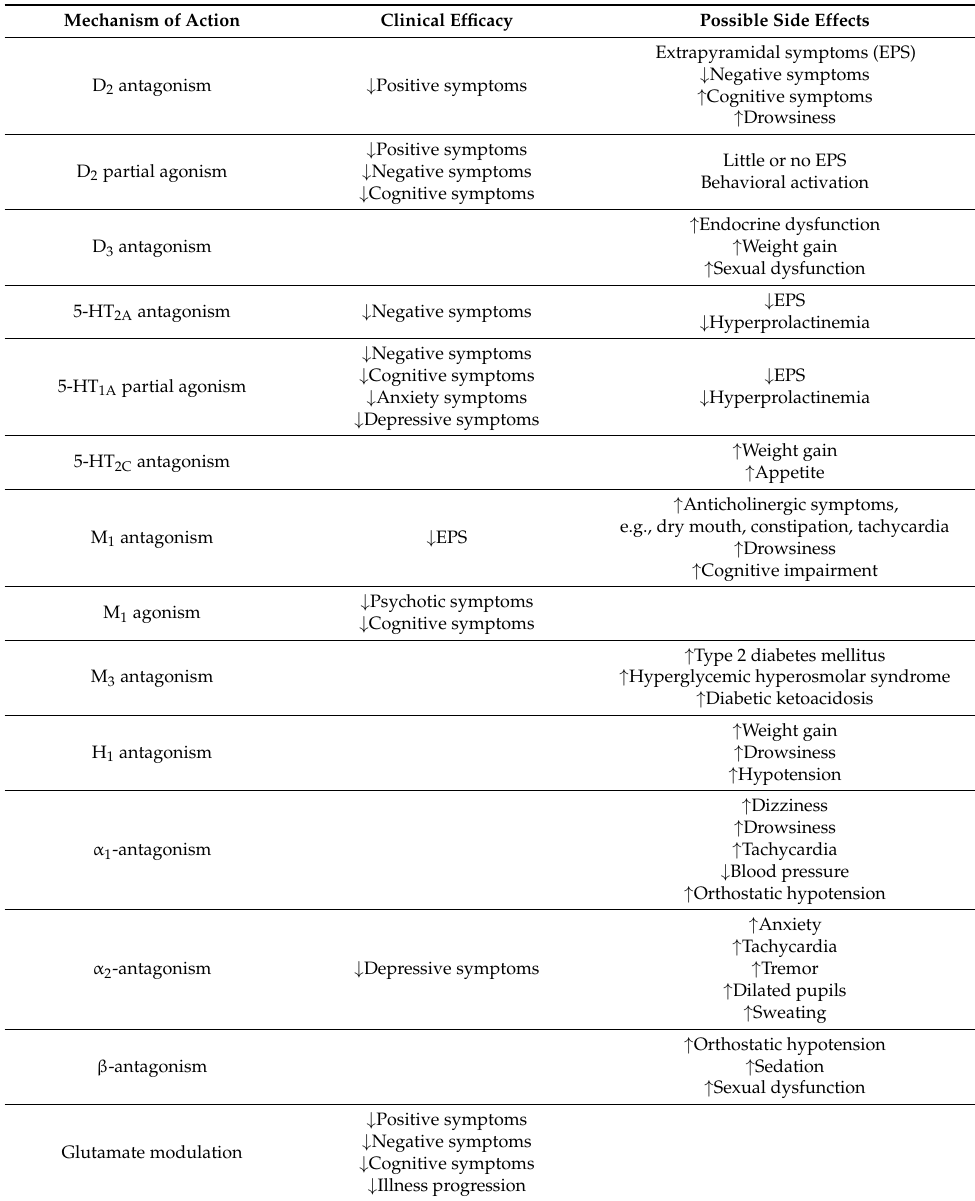
Potential clinical benefits and side effects related to the mechanisms of action of antipsychotics